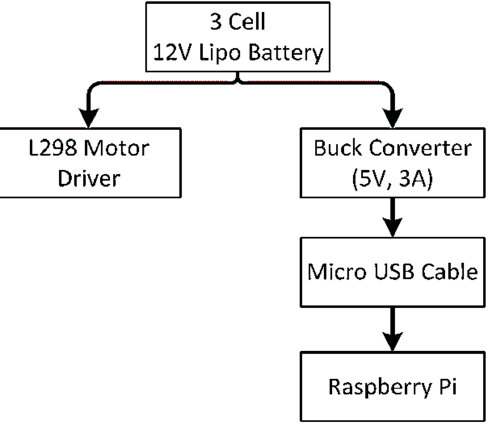
Figure 7. Power flow strategy.